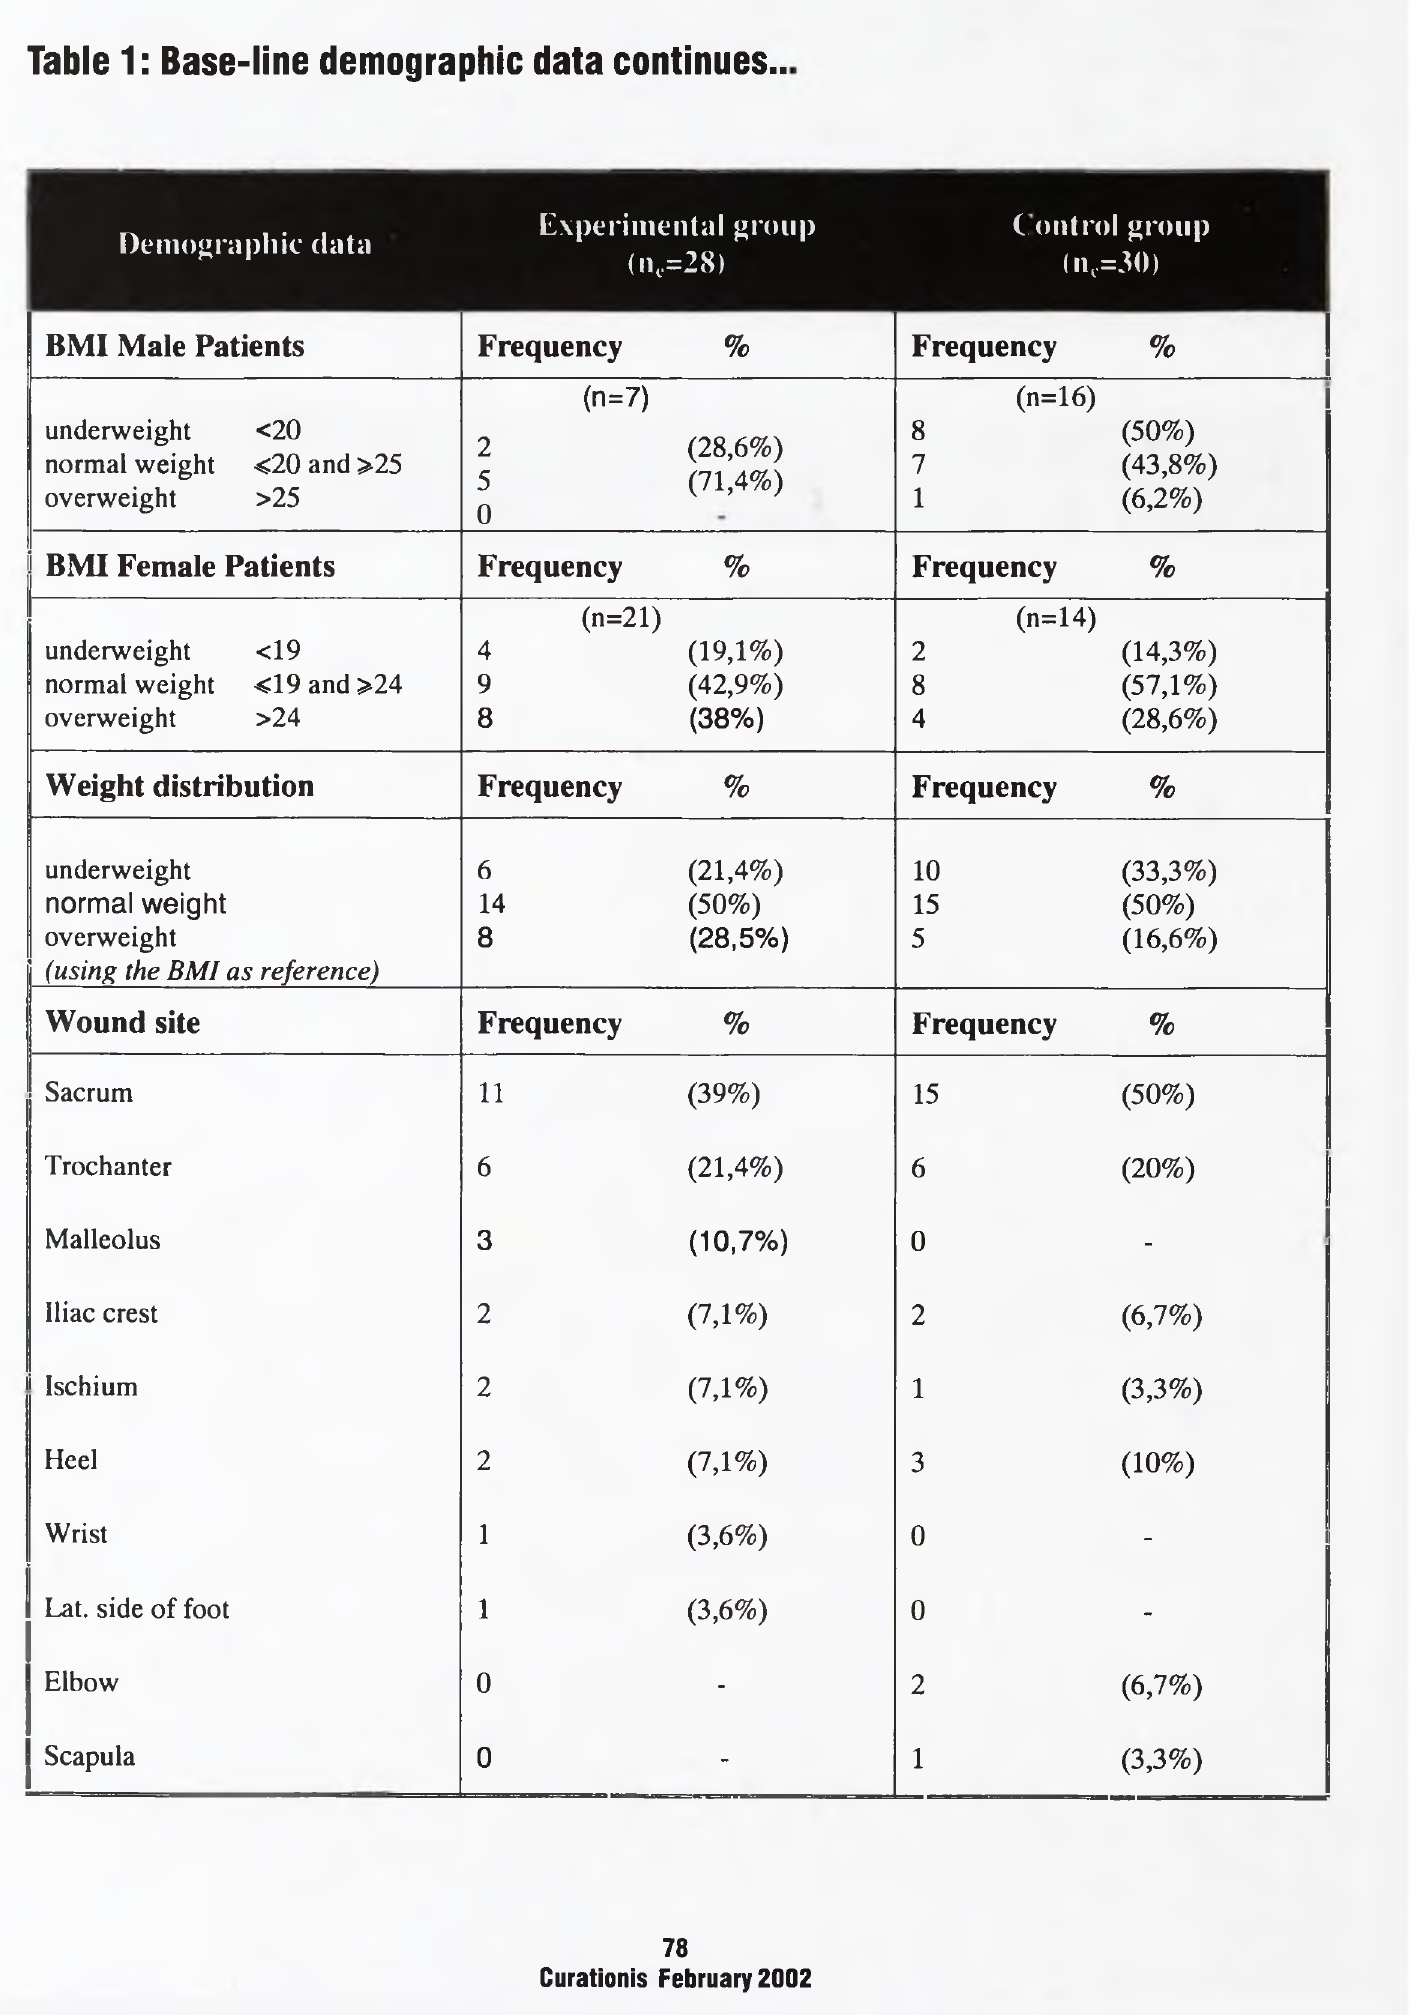
Table 1 : Base-line demographic data